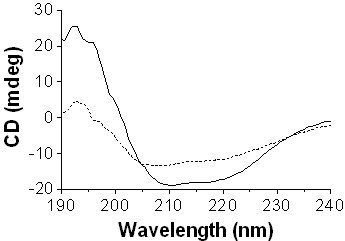
CD spectra of TrLAC1. measured under native (solid line) and thermal denaturing conditions (dashed line).